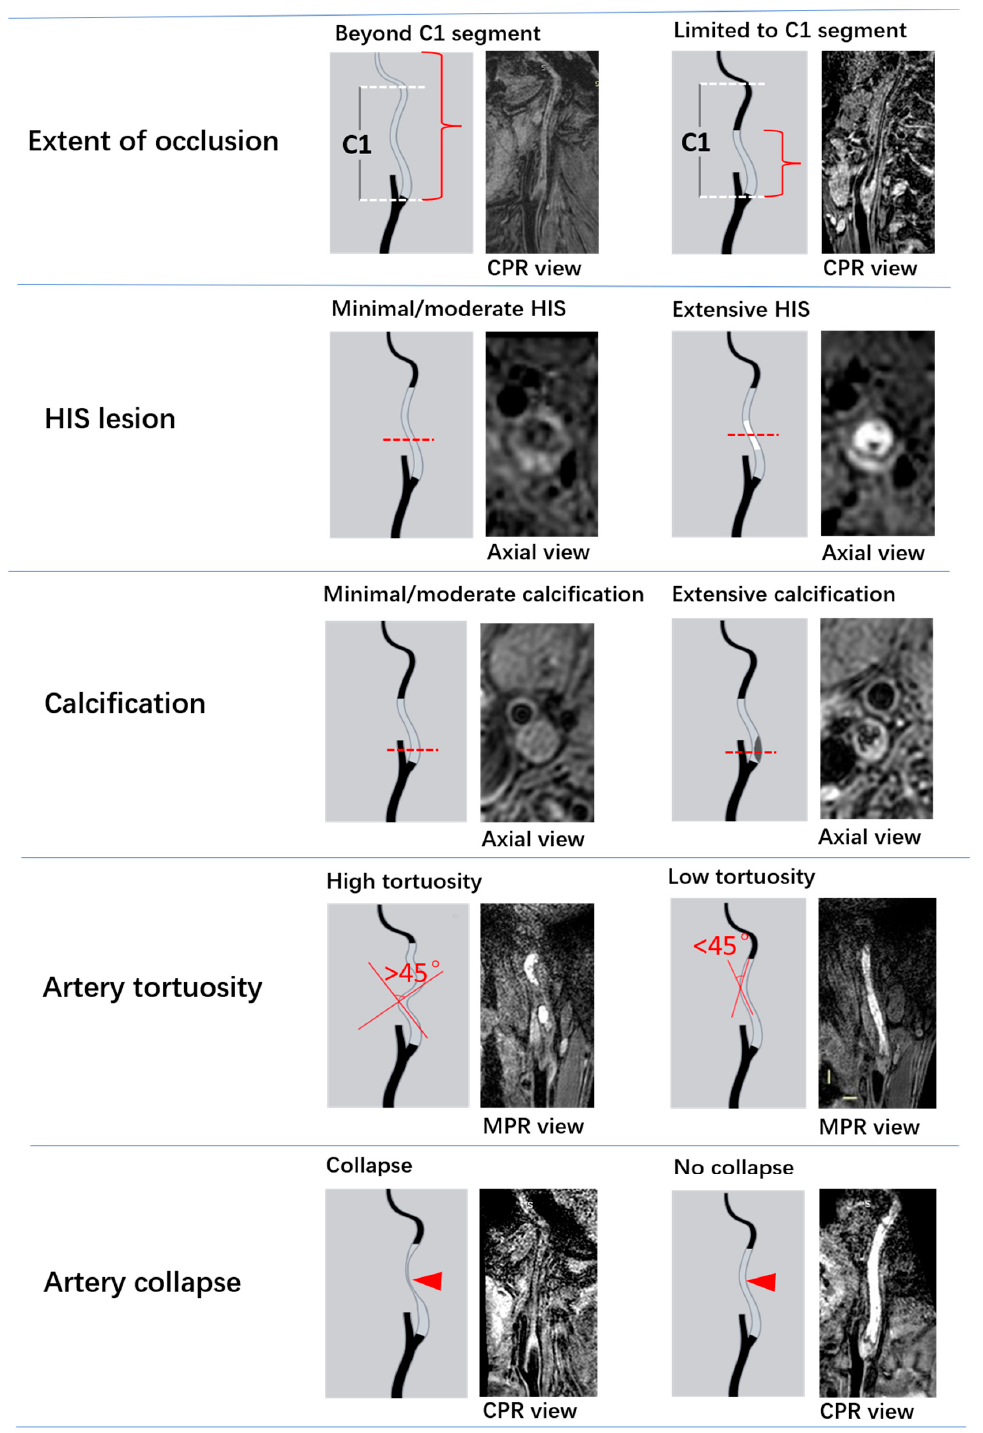
Figure 1. Illustrations of MR-VWI characteristics of